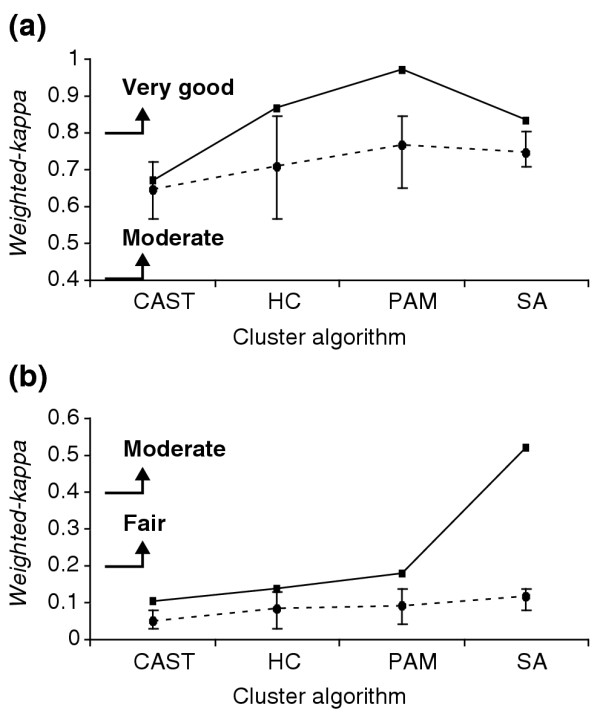
Comparison between consensus clustering and pairwise clustering. The weighted-kappa score for consensus clustering (solid line) calculated by comparing consensus clusters to the corresponding individual clustering algorithm is shown relative to mean pairwise weighted-kappa score for each single method compared to all other single methods (broken line) for (a) the ASC dataset, (b) the B-cell lymphoma dataset. The maximum and minimum weighted-kappa scores for the collection of single methods are indicated by the error bars. The definitions of weighted-kappa scores are derived from Table 1. The parameter settings for the clustering algorithms are: HC and PAM, 13 clusters for the ASC dataset and 40 for the B-cell dataset; CAST, affinity level 0.5; and SA, θ0 = 100, c = 0.99994 and number of iterations = 1,000,000.